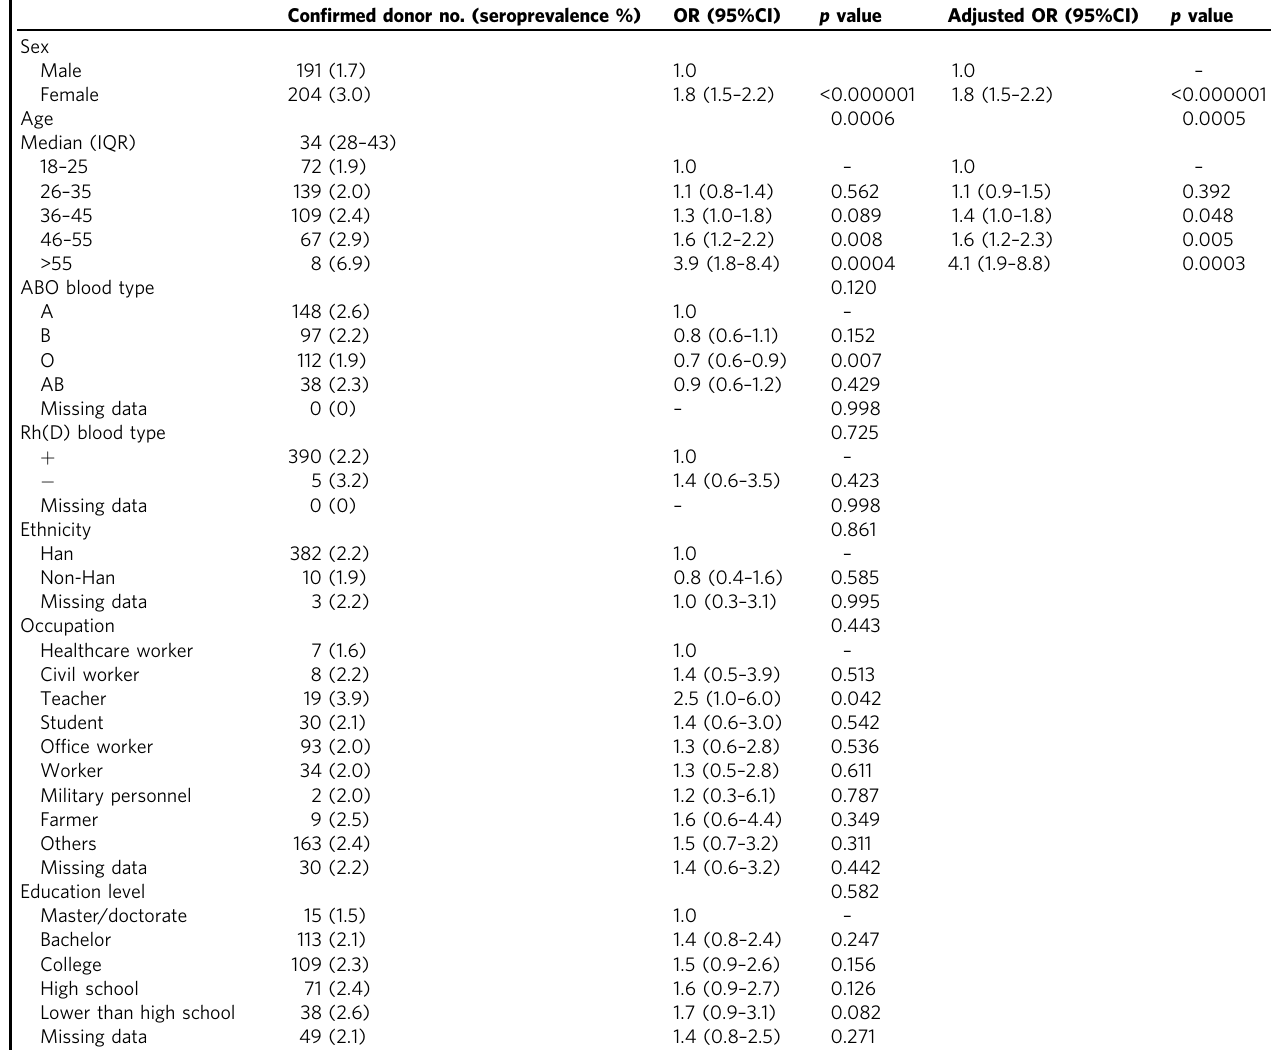
Table 3 Binary logistic regression analysis of risk factors for the con fi rmed seroprevalence among blood donors in